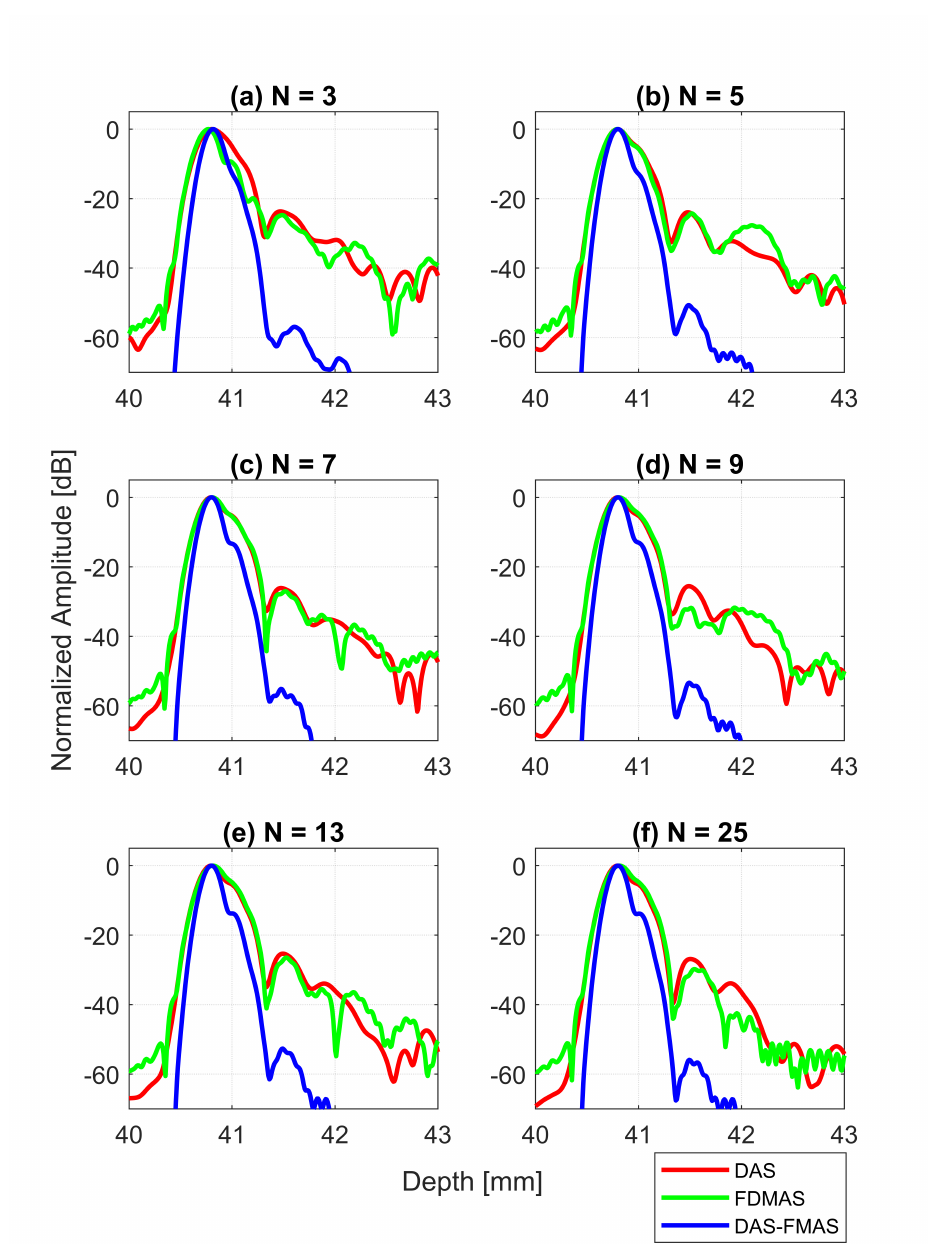
Figure 11. Axial beam profiles for the wire target at a 30 mm depth with DAS, FDMAS and DAS- FMAS using ( a ) N = 3, ( b ) N = 5, ( c ) N = 7, ( d ) N = 9, ( e ) N = 13 and ( f ) N = 25. There are no significant differences in axial lobes between DAS and FDMAS for all numbers of compounding angles, whereas for DAS-FMAS the main lobes are narrowed and the side lobes are attenuated by an average 25